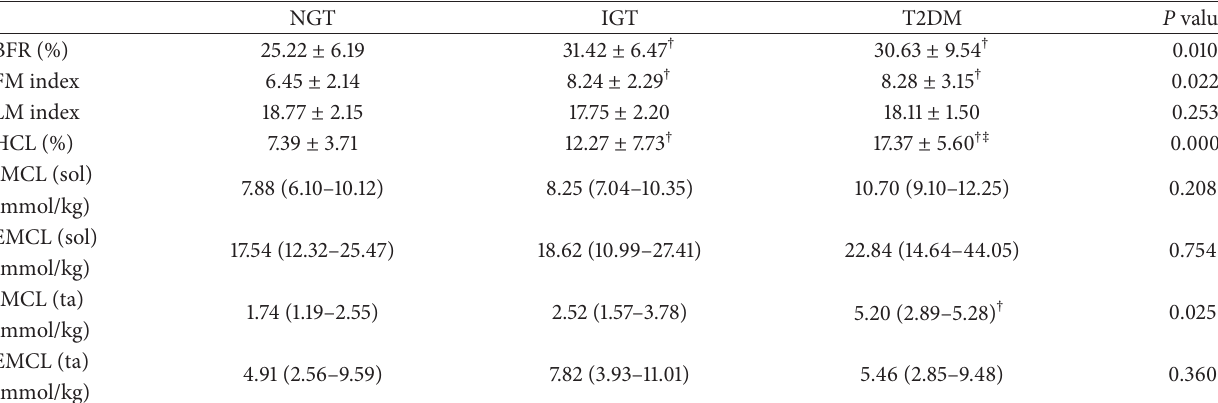
Table 3: Body fat composition, HCL, and skeletal muscle fat content.